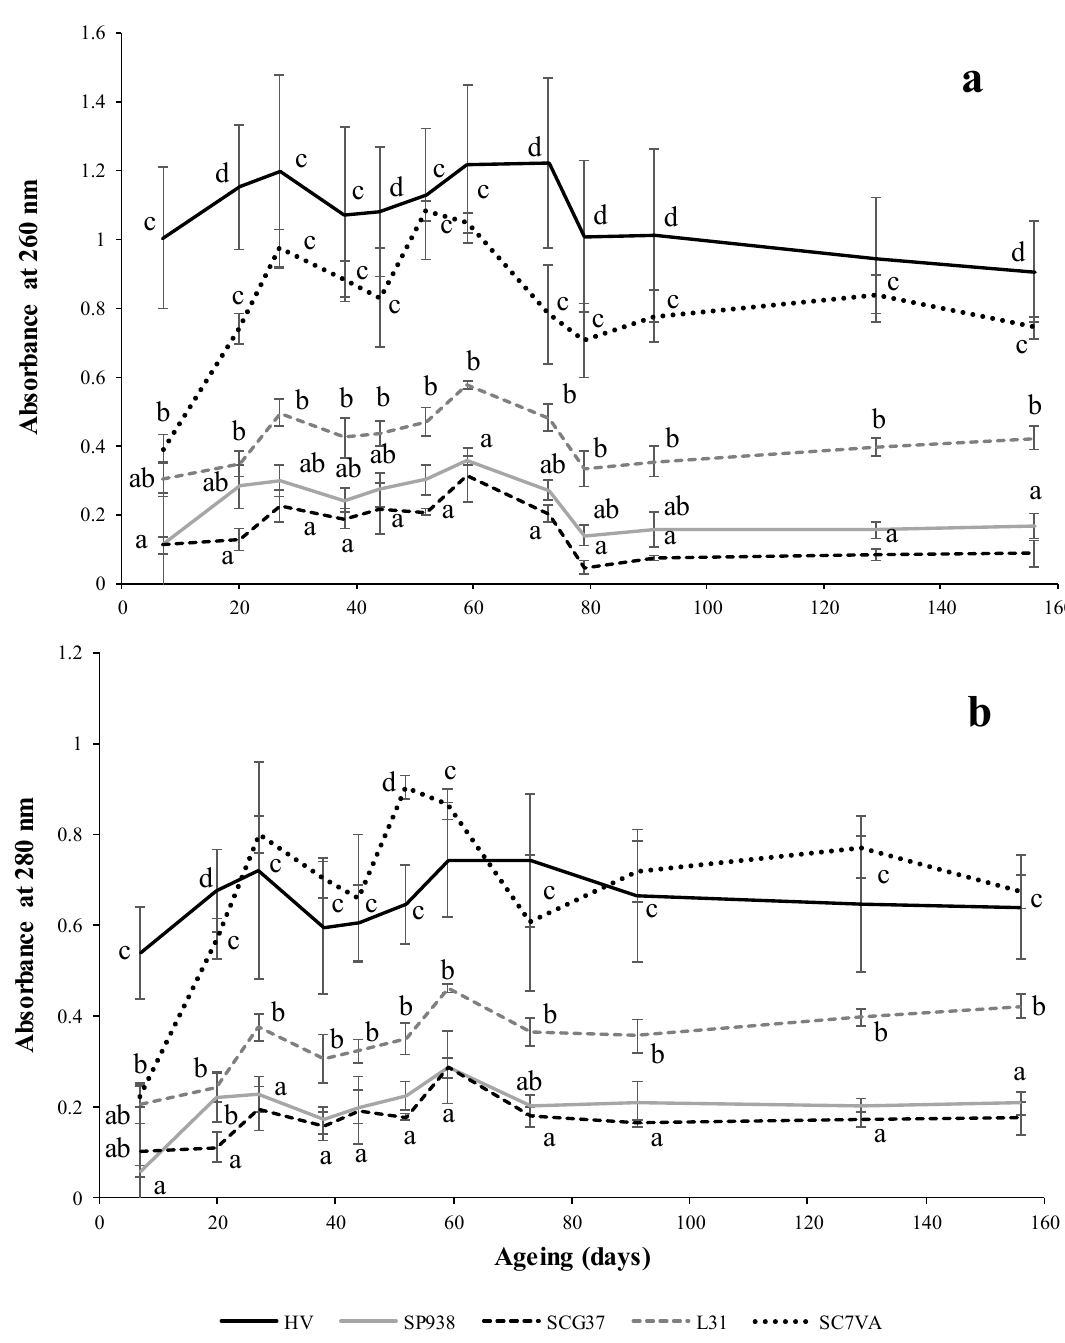
Figure 3. Evolution of the absorbance at 260 nm ( a ) and at 280 nm ( b ) in hydroalcoholic solutions, throughout 156 days of ageing on lees. HV ( Hanseniaspora vineae ); SP938 ( Schizosaccharomyces pombe strain 938); SCG37 ( Saccharomyces cerevisiae strain G37); L31 ( Lachancea thermotolerans strain L31); SC7VA ( Saccharomyces cerevisiae strain 7VA). Mean ± standard deviation of three replicates. Different letters in the same day indicate values with statistically significant differences ( p < 0.05).